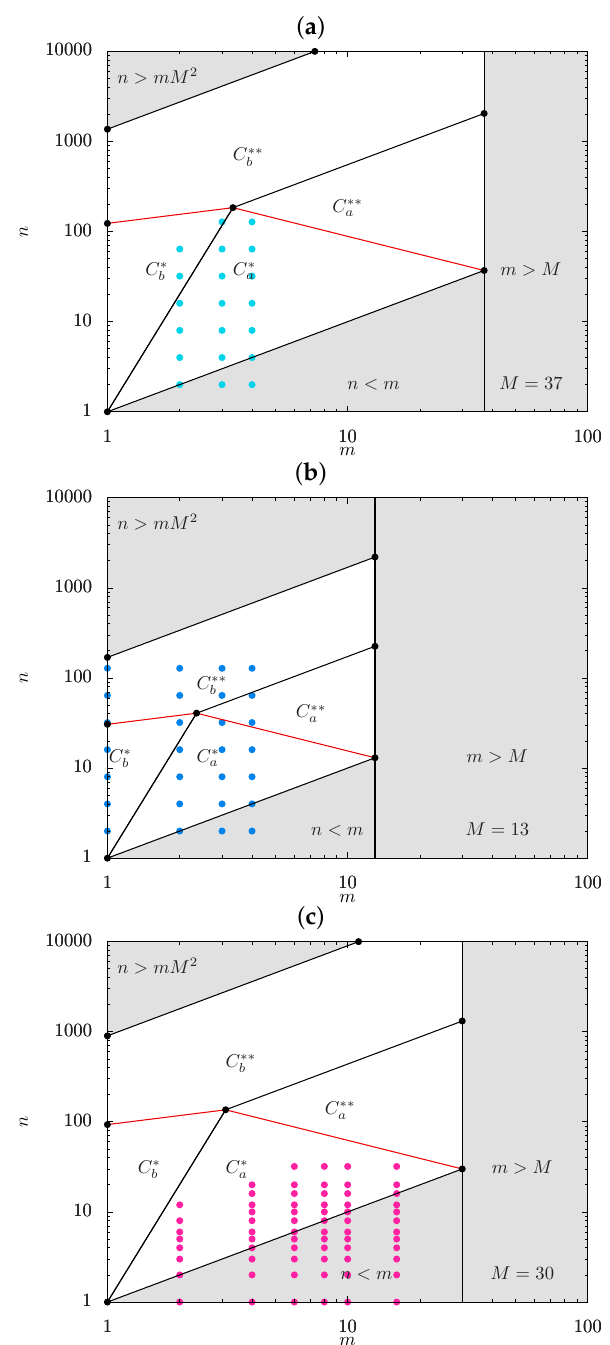
Figure 4. Scaling-type diagrams with positions of boundaries calculated specifically for DP M = 37 ( a ) and DP M = 13 ( b ) of the backbone, respectively, together with ordered set of symbols marking the architectural parameters of bottlebrush strands modeled in MC simulations and ( c ) for M = 30 in MD simulations.Shaded area with n While positions of the boundaries in Figure 4 are specified with accuracy of the numerical prefactors on the order of unity, it is still expected that MC simulations for M = 37 (Figure 4a) with small values of 1